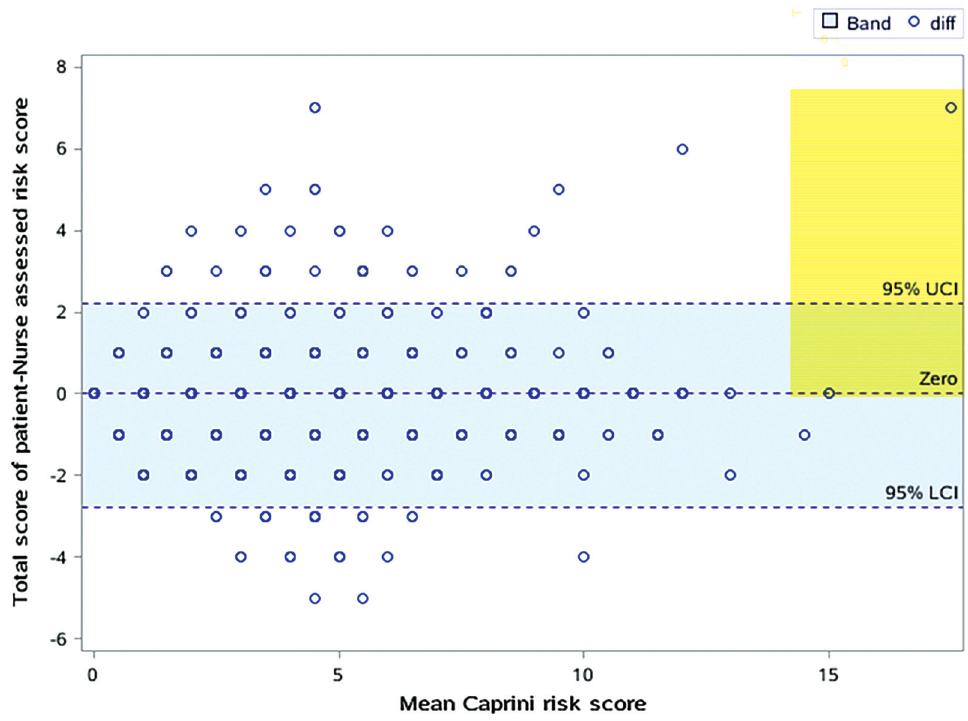
Fig. 3 Bland-Altman plot of patient-completed and nurse-completed Caprini risk score ( n ¼ 1017). No trend for extreme values were found through this fi gure.